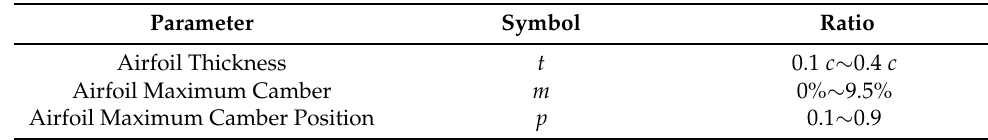
Table 2. The range of changes permitted in the determination of the components of the flap geometry in the optimization